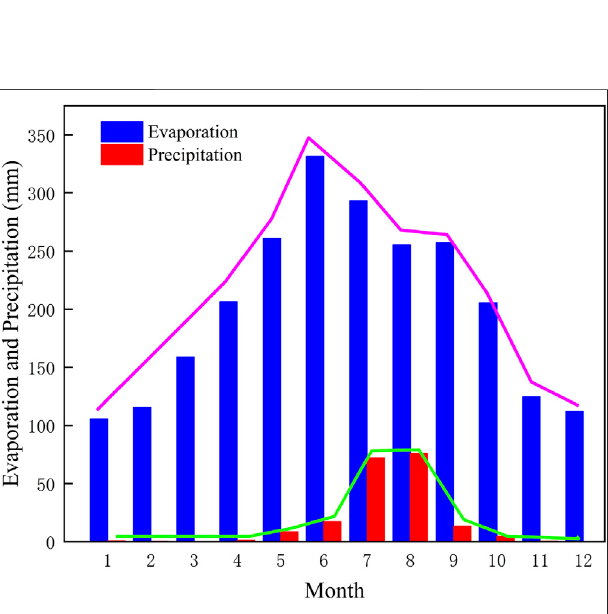
Frontiers in Earth Science |